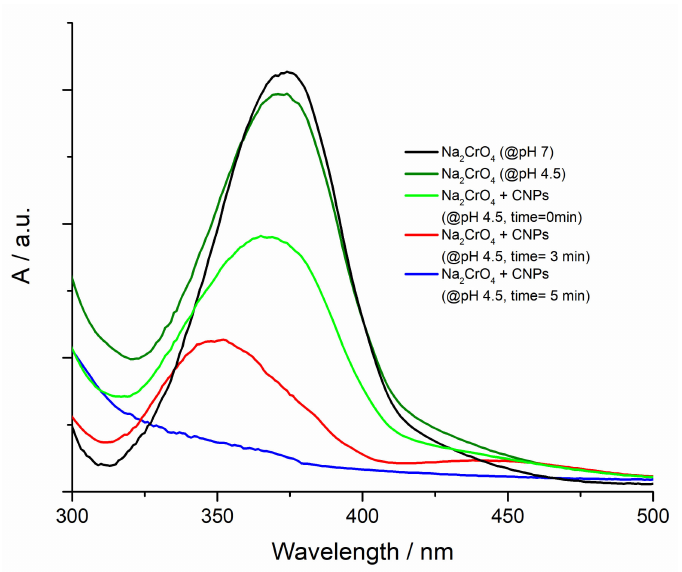
Figure 6. CNPs effect on Vis spectrum of Cr(VI) acid solution during the treatment and Vis spectrum of Cr(VI) at neutral pH in presence of CNPs (black line) for